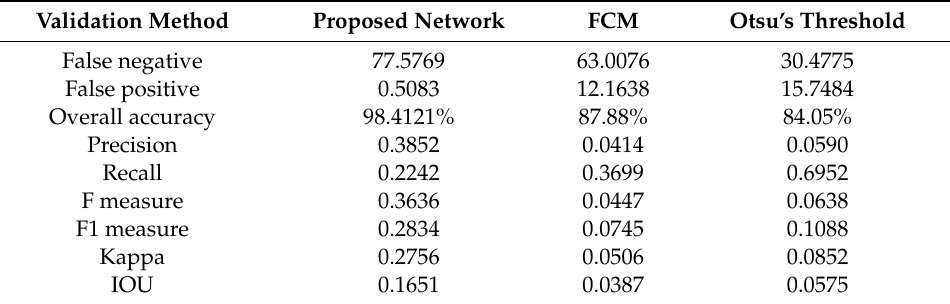
Table 7. Accuracy of the model in the Xiamen area.